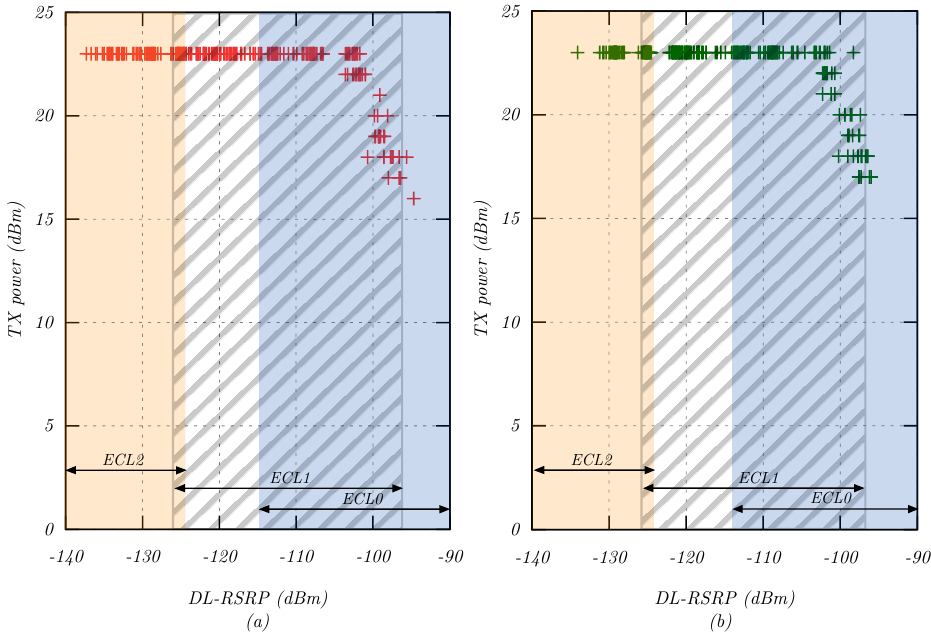
Figure 8. UE transmit power P TX , UE as a function of downlink RSRP signal level for ( a ) uplink and ( b ) downlink